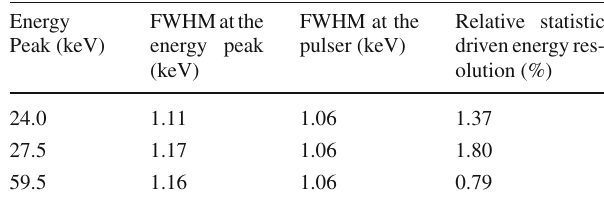
Table2 TheFWHMofthreeenergypeaksfromAm-241andthepulser peak at 400 V when the source was placed at the bottom of the cryostat. The energies presented here are the expected values. For each energy peak, the relative statistic driven energy resolution was determined by subtracting in quadrature the FWHM at the pulser from the FWHM at the energy peak and then divided by the energy Energy FWHMatthe FWHM at the Relative statistic Peak (keV) energy peak pulser (keV) drivenenergyres- (keV) olution